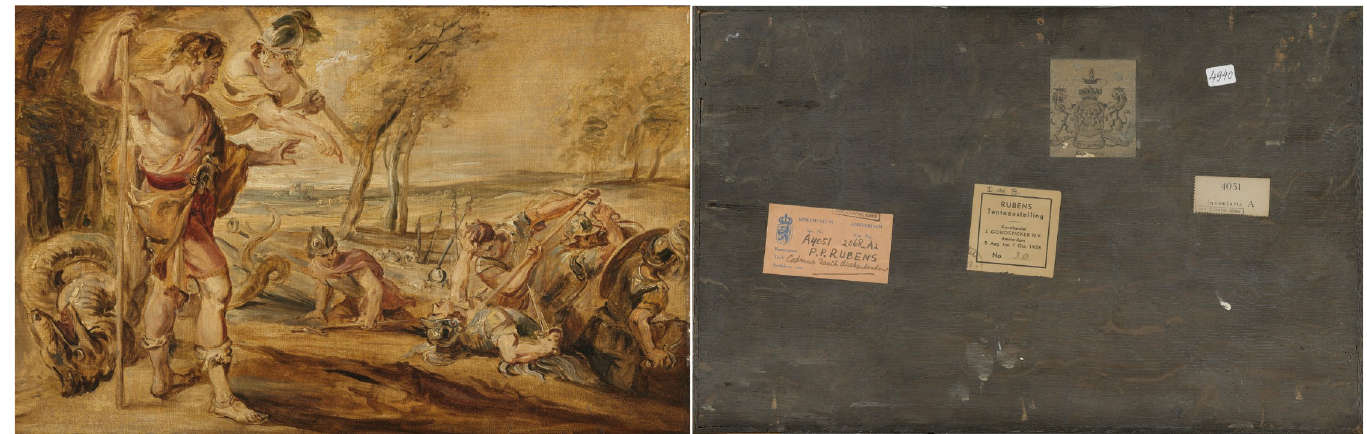
Fig 1. Front and back of the Rijksmuseum’s panel painting Cadmus Sowing Dragon’s Teeth (http://hdl.handle.net/10934/RM0001.COLLECT.5320). The strips of oak that surround the panel can be observed on the photo of the reverse.